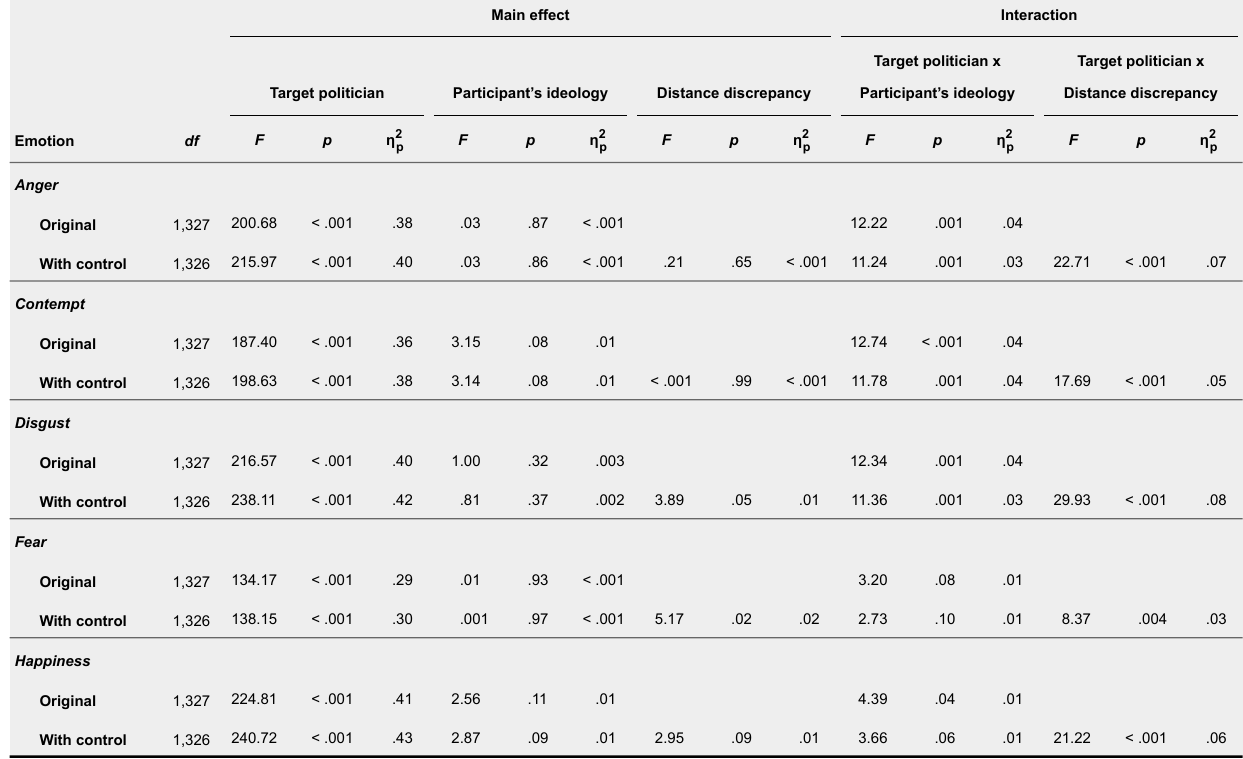
Study 2 ANOVA Results While Controlling for Ideological Distance